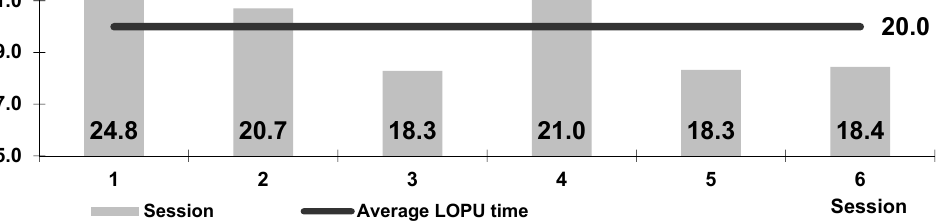
Figure 8. Timing of the L-OPU procedure in sheep in consecutive sessions.